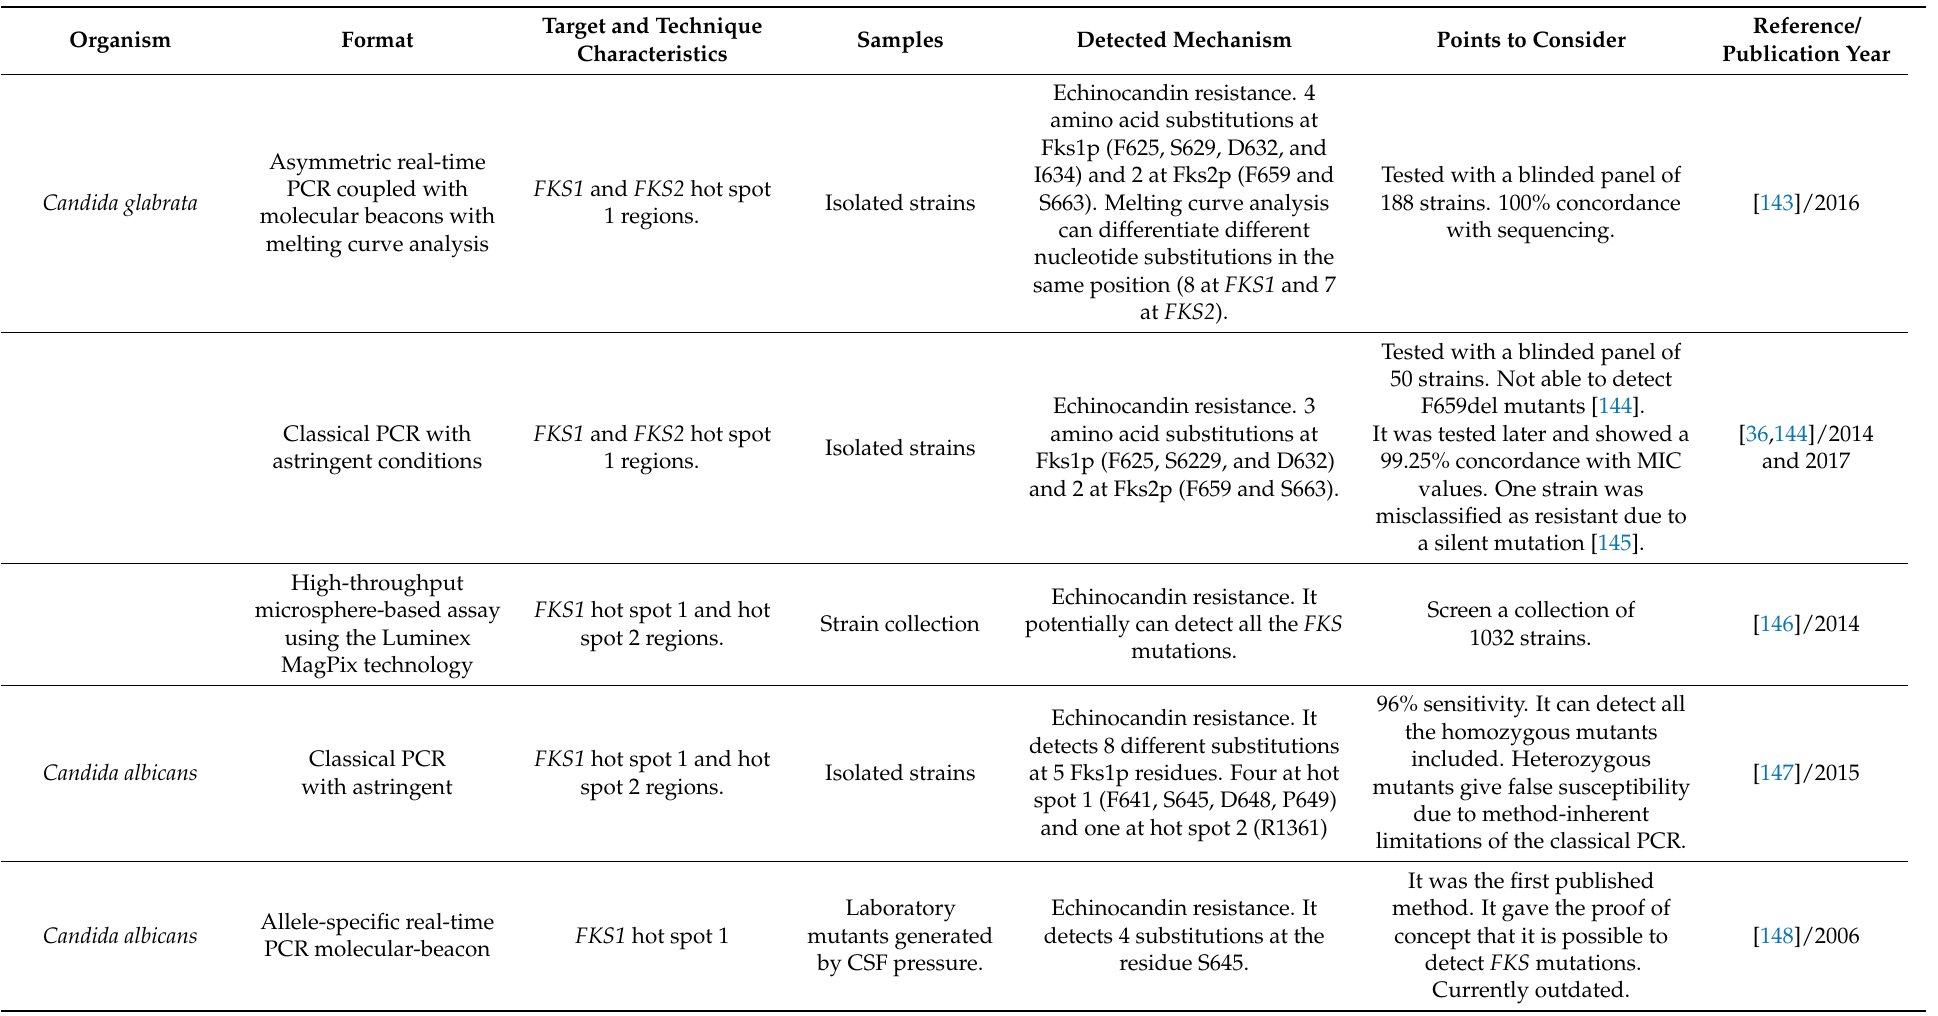
Table 2. Molecular tools for the detection of mechanisms of azole and echinocandin resistance in Candida